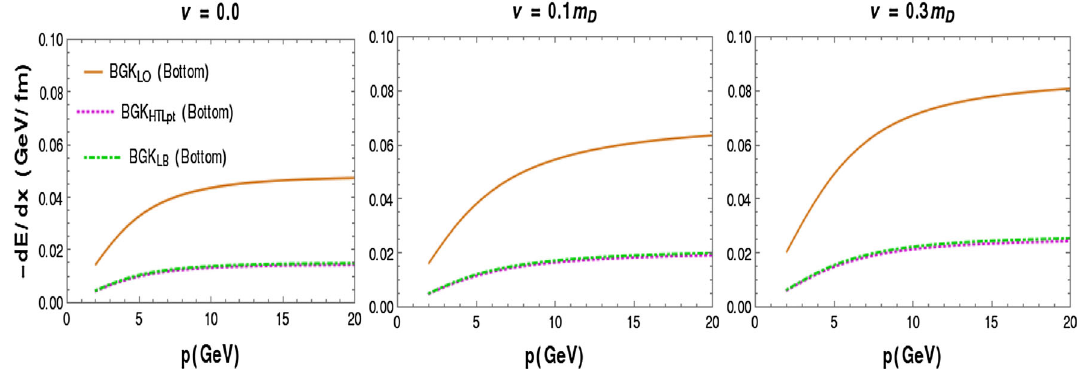
Fig. 2 Energy loss of the bottom quark ( m = 4 . 5 GeV ) for various values of ν at T = 2 T c and different